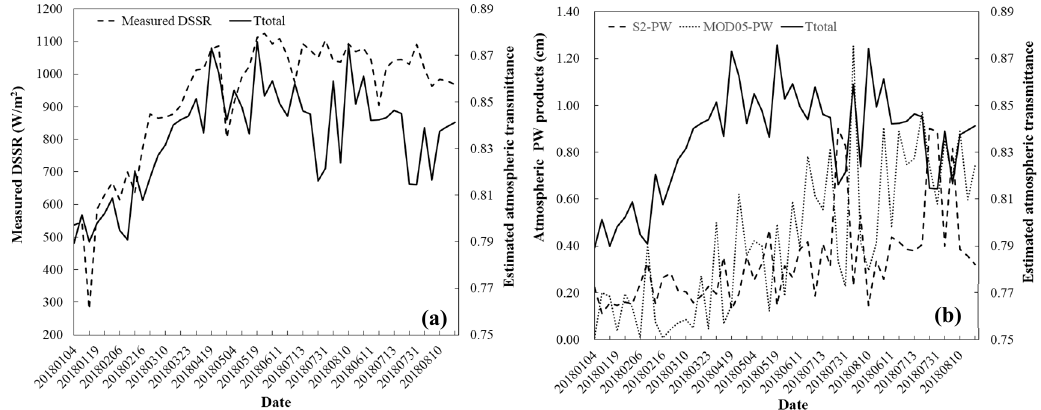
Figure 10. Reliability analysis of the atmospheric transmittance based on an S2 inversion: ( a ) ground DSSR measurements and the estimated atmospheric transmittances at the two AWSs at the S2 overpass time; ( b ) S2 PW versus MODIS PW.